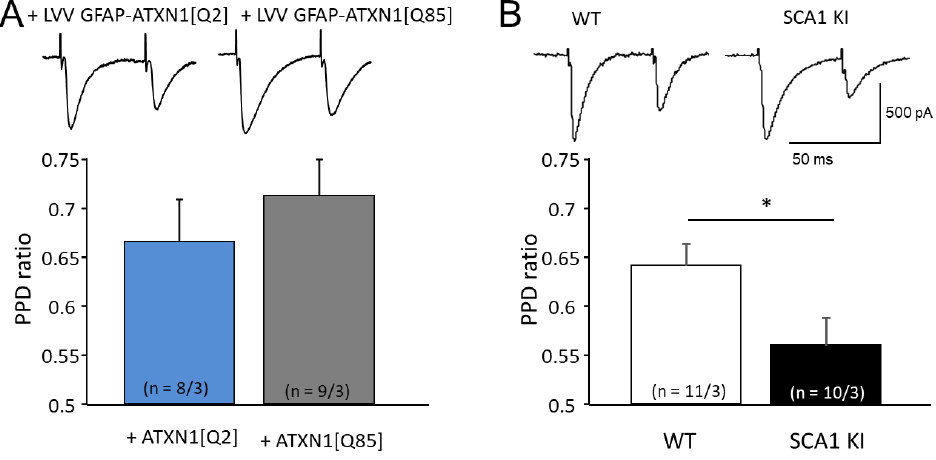
Figure 4. Impairment of presynaptic short-term plasticity in CF-PC synapses in SCA1 models. ( A ) PPD ratio is preserved in LVV-GFAP-Flag-ATXN1[Q85] injected mice as compared to LVV-GFAP- Flag-ATXN1[Q2] controls, indicating relatively preserved function of CF-PC synapses. ( B ) Enhanced PPD reflecting impaired presynaptic function of CF-PC synapses in SCA1 KI mice. The numbers ( n ) of tested PCs and animals (PCs/animals) are shown in parentheses. Asterisks indicate a statistically significant difference compared with respective controls ( t -test; * p < 0.05).